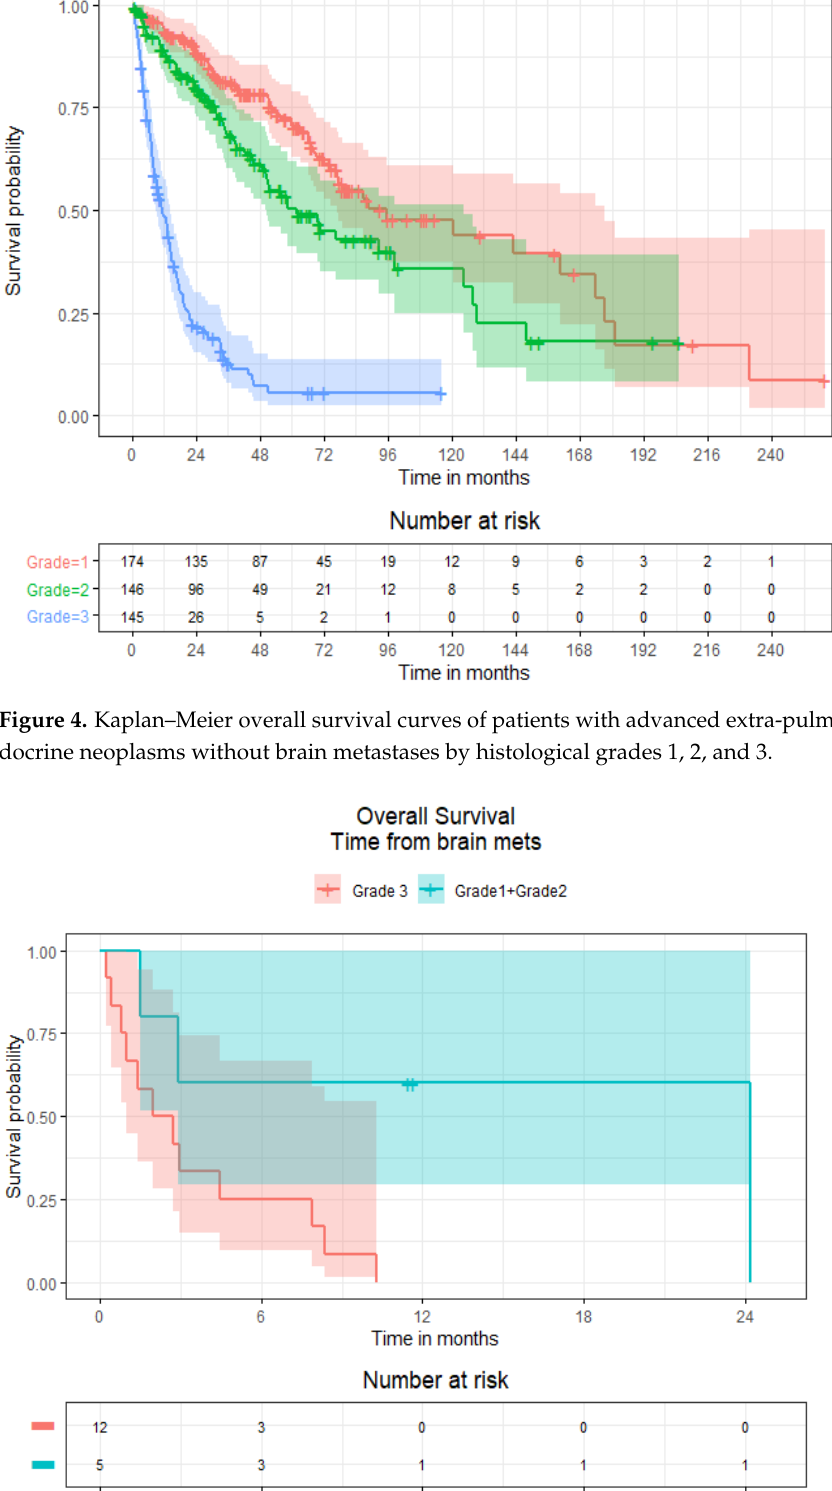
Figure 5. Kaplan–Meier survival curve from BM diagnosis to death for patients with grades 1 + 2 Figure 5. Kaplan – Meier survival curve from BM diagnosis to death for patients with grades 1 + 2 (grouped) versus 3 (grouped) versus 3 disease. Table 5. Univariate and multivariate Cox regression analyses of factors associated with OS in pa- tients with EP – NENs and BMs.